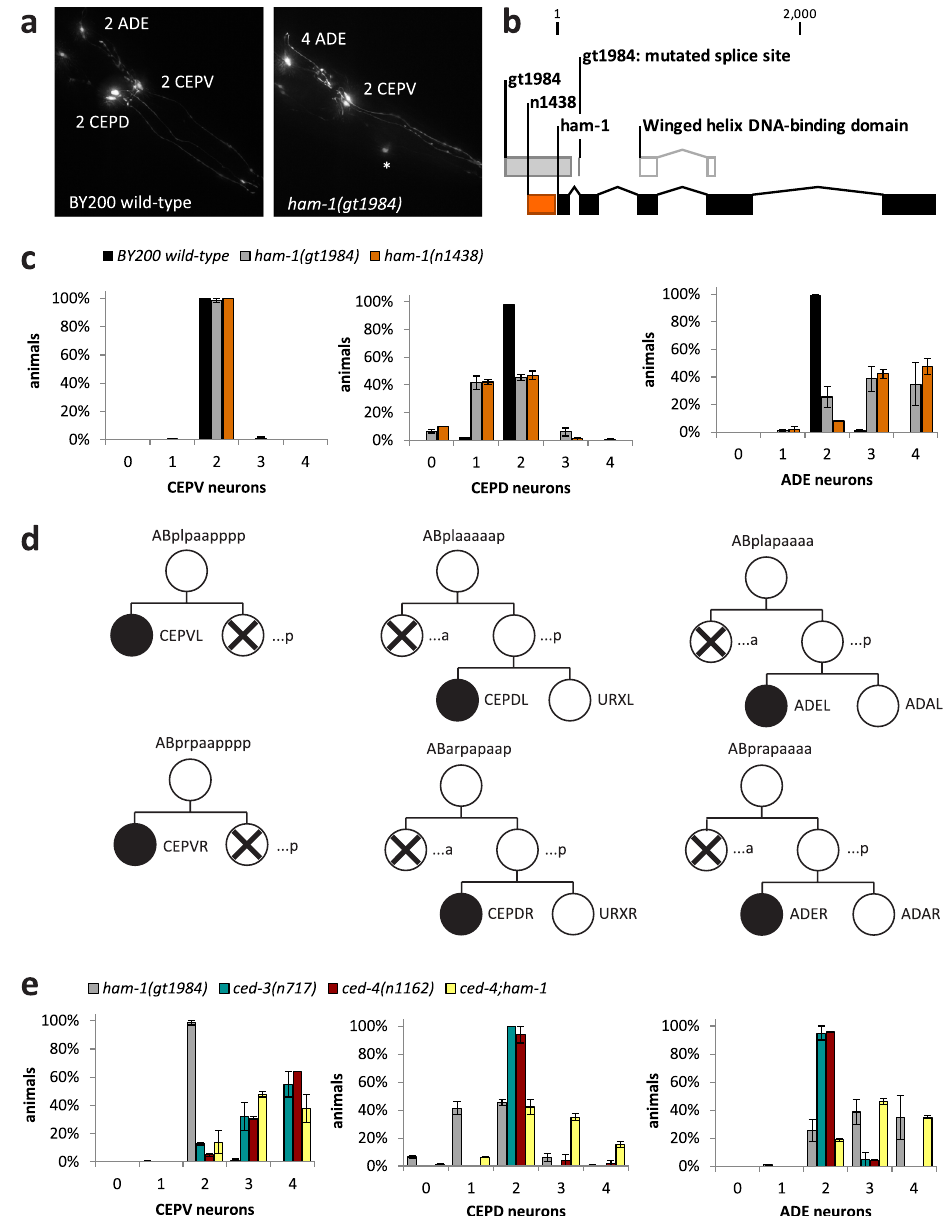
Figure 1. Distinct defects caused by ham - 1 mutation and genetic interactions with the apoptosis pathway in the lineages leading to C . elegans dopaminergic head neurons. ( a ) Dopaminergic head neurons in BY200 wild- type animals and in ham - 1 ( gt1984 ) mutants. The dorsal cephalic sensilla (CEPD) neurons are located more posteriorly than the ventral cephalic sensilla (CEPV) neurons. A misplaced CEPD neuron is marked with an asterisk. ( b ) ham - 1 gene structure with winged helix box DNA-binding domain (in white) and positions of mutations in ham - 1 ( gt1984 ) (in orange) and ham - 1 ( n1438 ) (in grey). gt1984 comprises a 554 base pair (bp) deletion spanning from the ham - 1 promoter into the first exon and also includes a splice site mutation at the start of the second exon. The 238 bp deletion of the n1438 allele is within the gt1984 deletion. ( c ) Number of dopaminergic head neurons in BY200 wild-type and ham - 1 mutant animals. Error bars = SEM of 2 − 4 biological replicates with 50 animals each. ( d ) Cartoon depicting the last divisions in the cell lineages that produce C . elegans dopaminergic head neurons (dopaminergic neurons are indicated with a solid black circle): left and right ventral cephalic sensilla neurons (CEPVL/R), left and right dorsal cephalic sensilla neurons (CEPDL/R) and left and right anterior deirids neurons (ADEL/R). Cells undergoing developmental apoptosis are marked with a cross. Daughter cells resulting from an anteroposterior division are labelled with ‘a’ and ‘p’, respectively, while daughter cells resulting from a left-right division are labelled with ‘l’ and ‘r’, respectively, starting from the ‘AB’ precursor cell. ( e ) Number of dopaminergic head neurons in the ham - 1 mutant, in the apoptosis pathway mutants ced - 3 and ced - 4 and in the ced - 4 ; ham - 1 double mutant. Error bars = SEM of 2 − 4 biological replicates with 50 animals